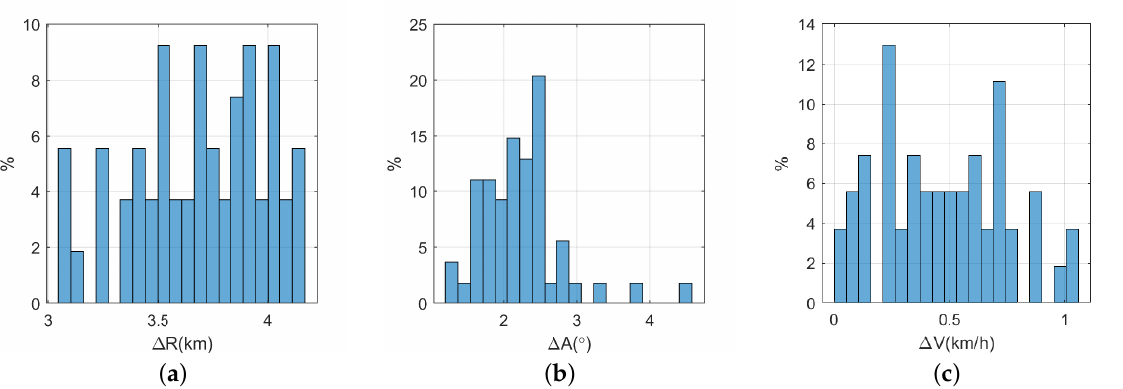
Figure 13. Kinematic parameter error distributions for target 3. ( a ) Range error distribution. ( b ) Azimuth error distribution. ( c ) Doppler velocity error